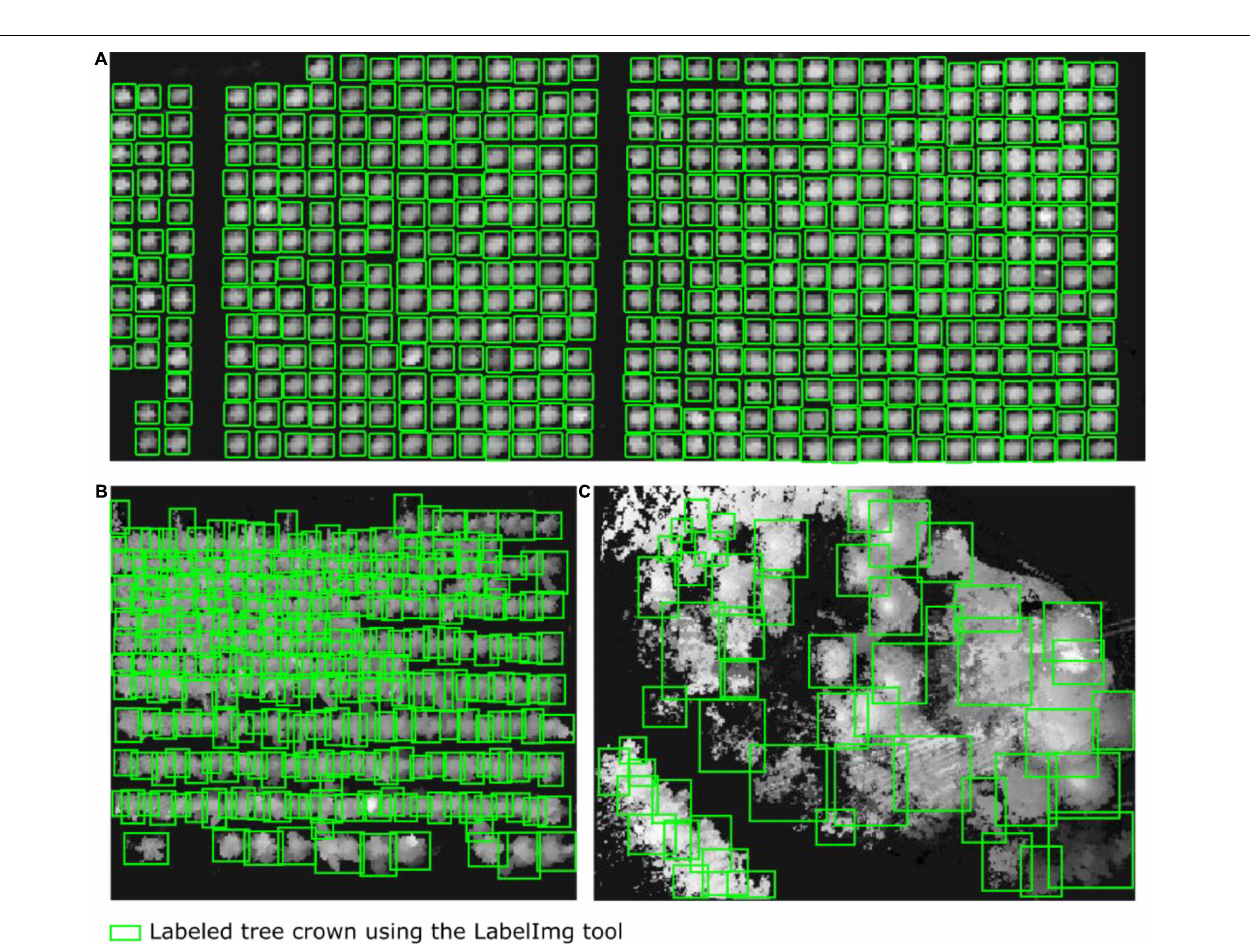
Frontiers in Plant Science |